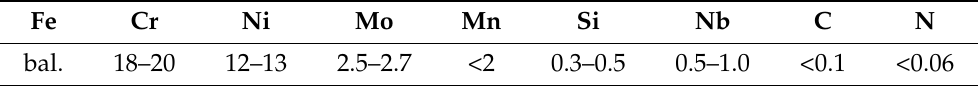
Table 1. Nominal composition (wt.%) of the 316Nb stainless steel